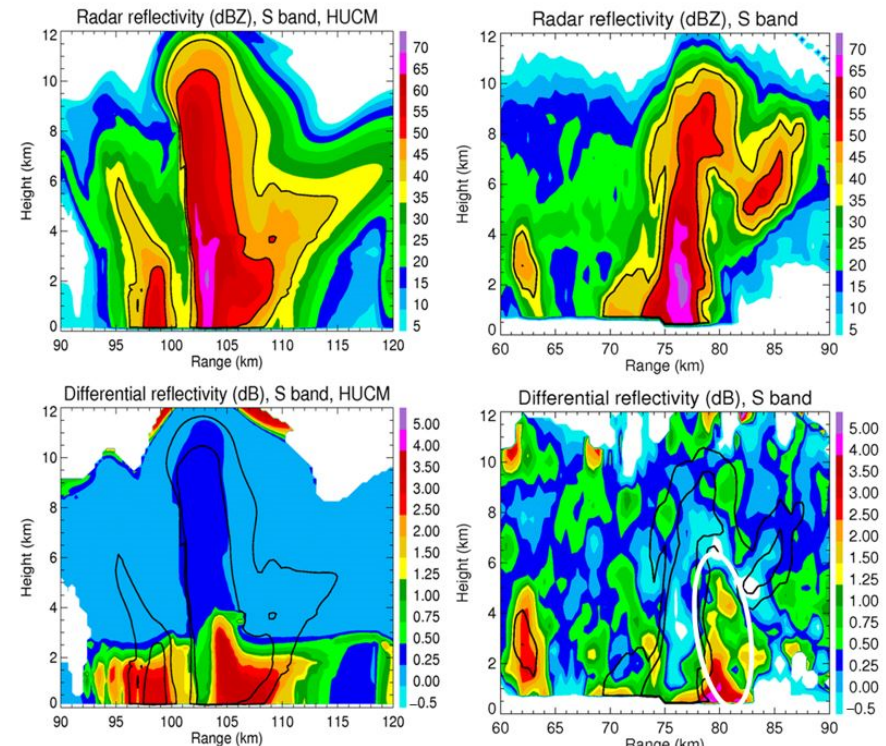
Figure 3. Fields of ( left ) simulated and ( right ) observed ( top ) Z and ( bottom ) Z DR in the vertical cross-section of an Oklahoma hailstorm on 2 February 2009 at the moment of its maximal development. Overlaid are 40- and 50-dBZ reflectivity contours. The white oval in the bottom right panel encloses the observed Z DR column. Note that the horizontal distances in the model and radar coordinates are different. From Ryzhkov et al. [15].